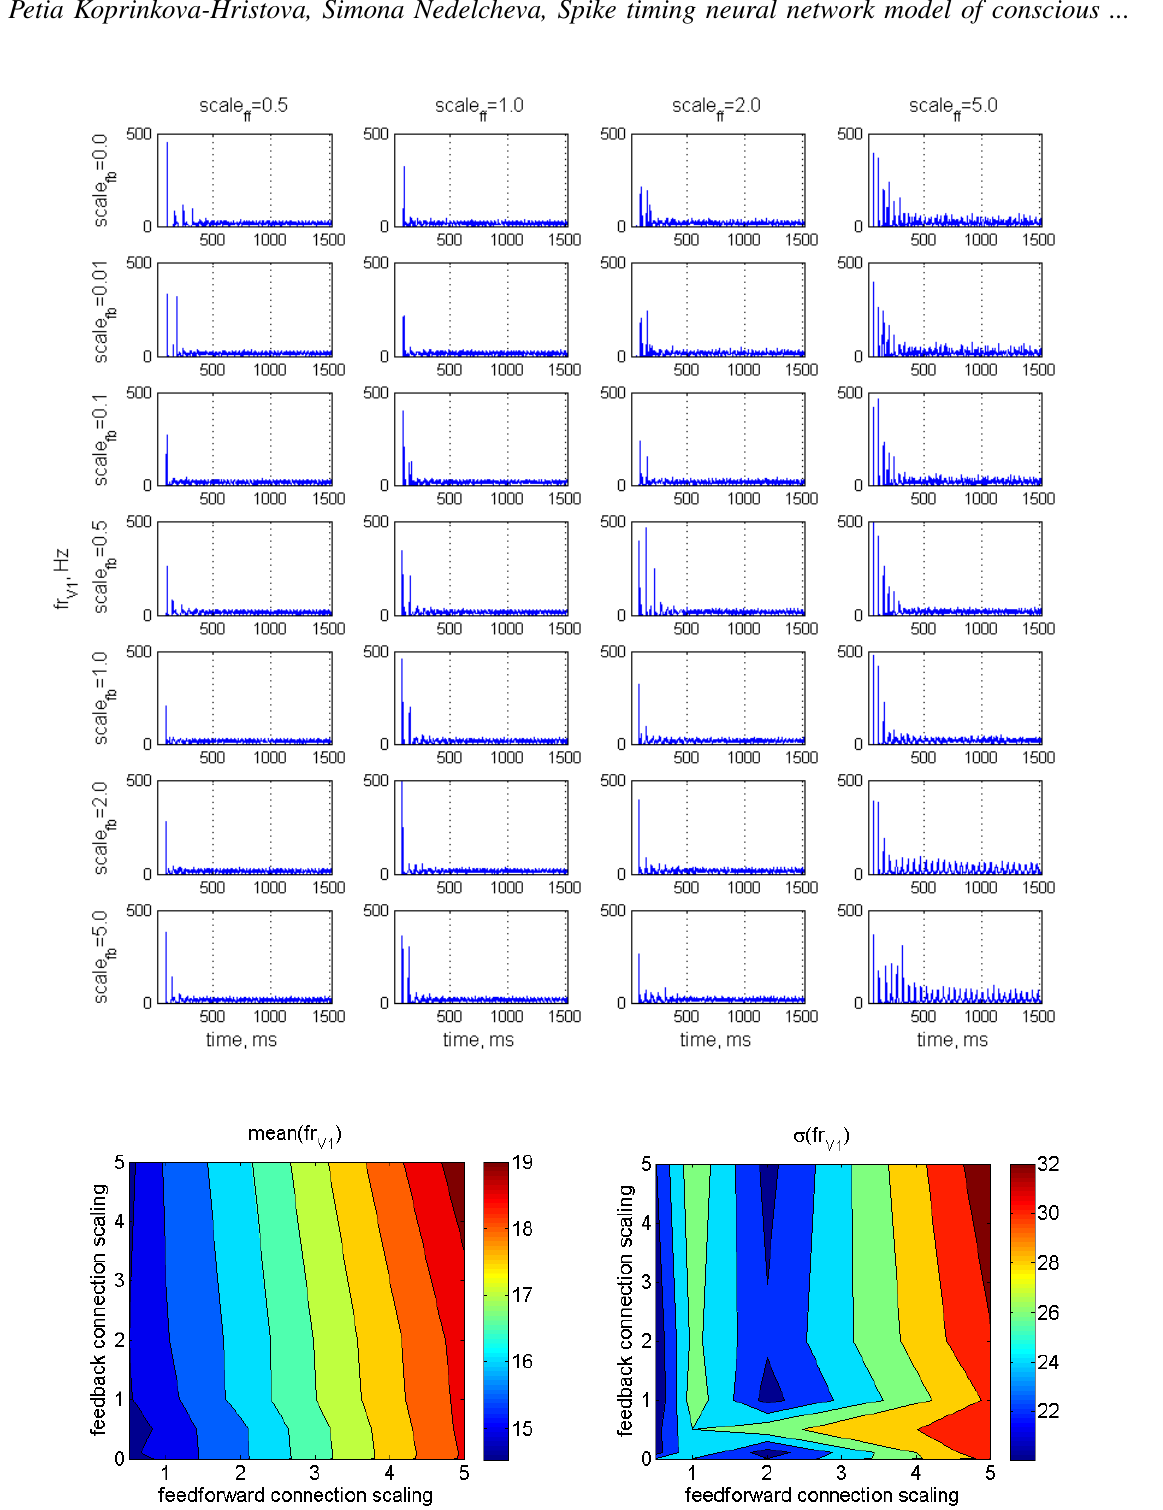
Fig. 4. Spiking activity in V1 (top) and its mean (bottom left) and variance (bottom right).